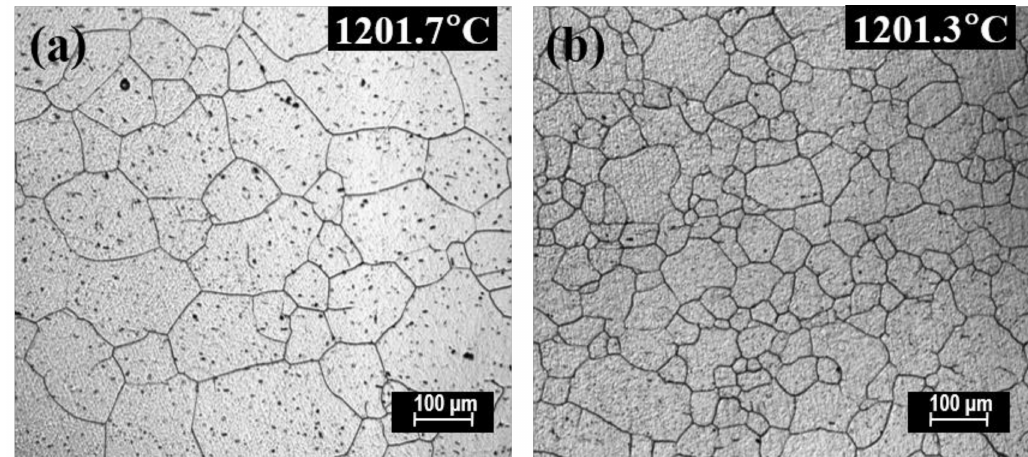
Figure 16. Austenite grains morphology after heating up to 1200 ◦ C in the CLSM experiment: ( a ) No.1; ( b )